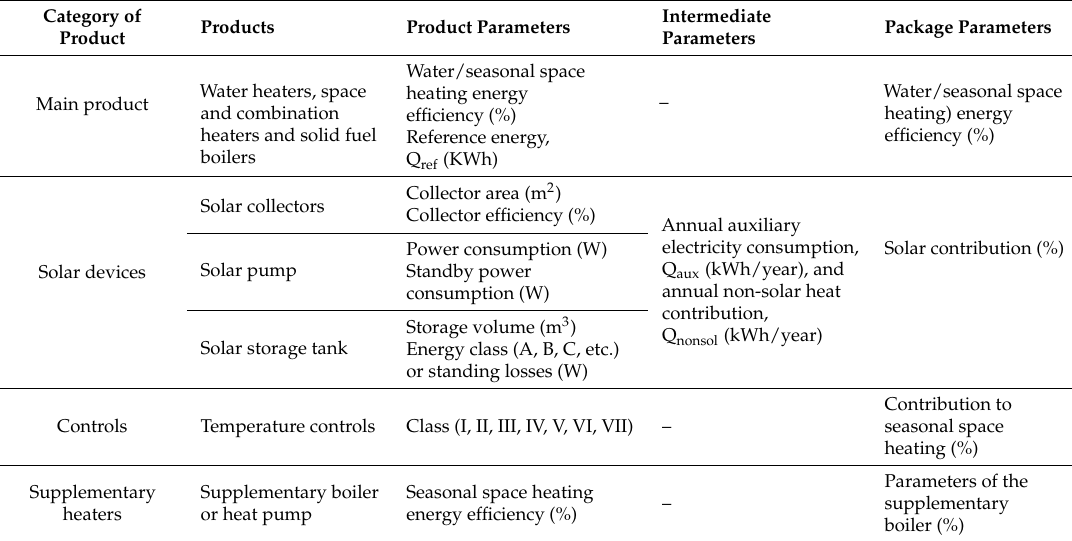
Table 2. Technical parameters involved in the calculation of the package energy